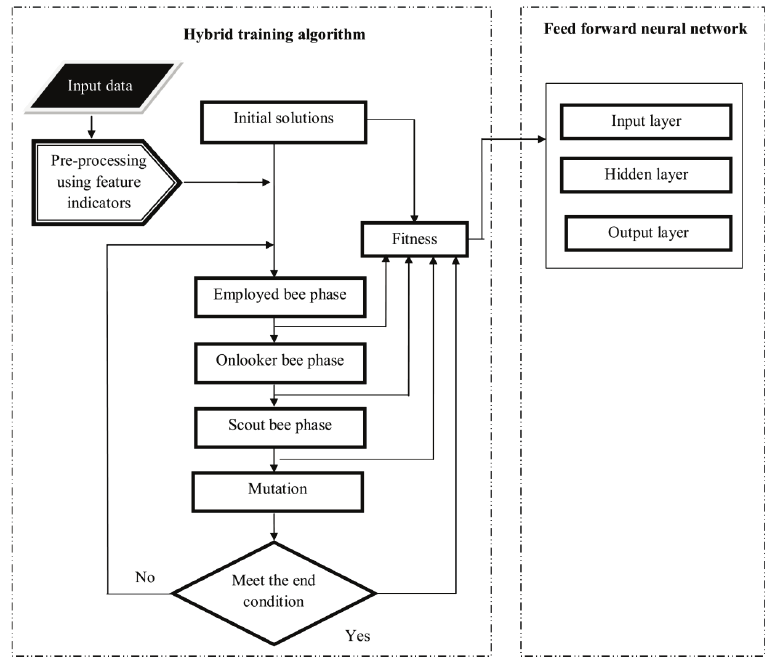
Fig.5. Flowchart of rainfall prediction